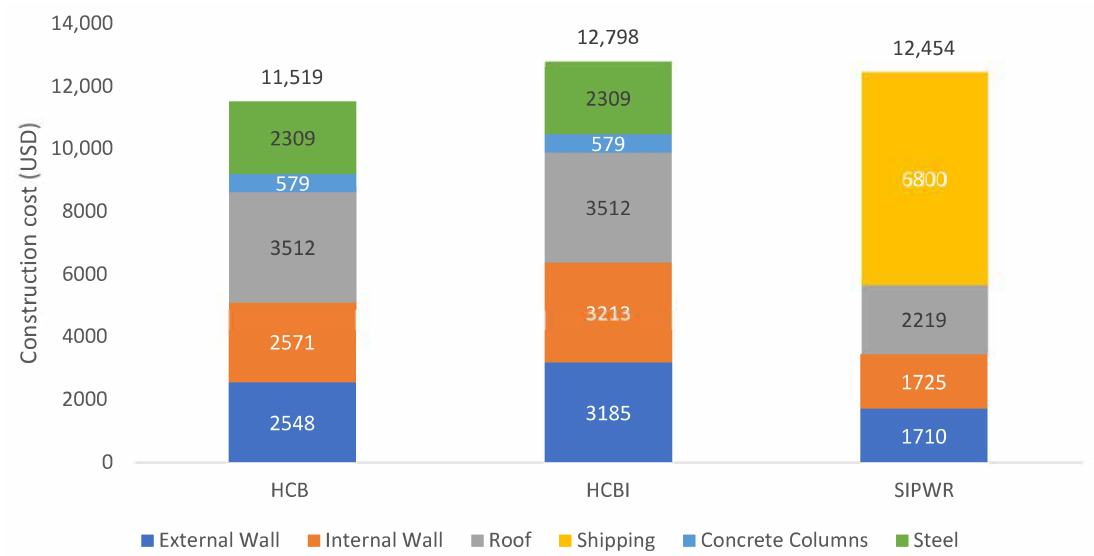
Figure 7. Construction cost across the Hollow Core Block (HCB), Hollow Core Block-Insulated (HCBI) and the Structural Insulated Panel Wall (SIPWR) types for material cost of 12 USD/m 2 for Structural Insulated Panels.